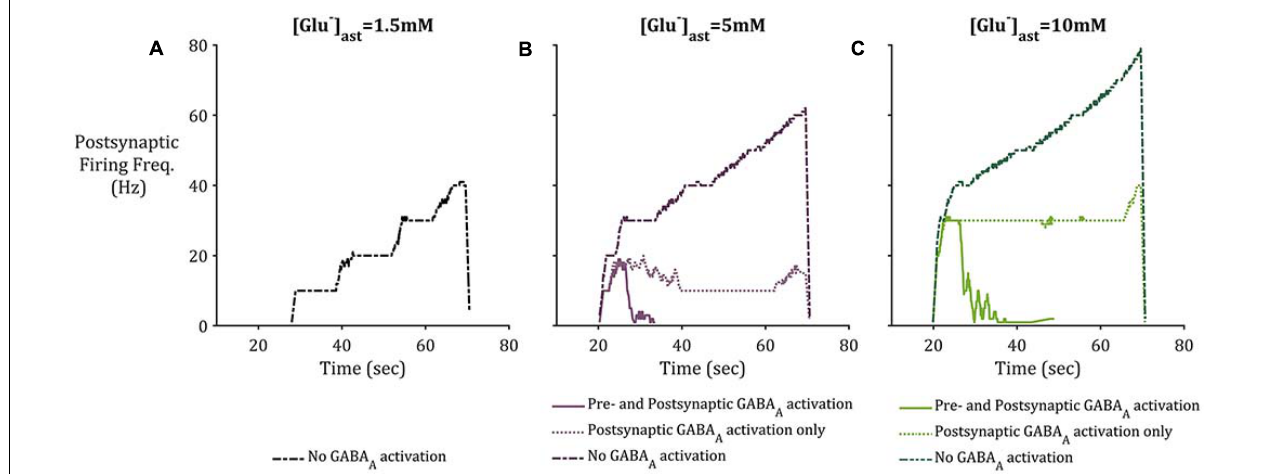
FIGURE 7 | Postsynaptic neuronal firing frequency where (A) basal [Glu] ast = 1.5 mM, (B) basal [Glu] ast = 5 mM, and (C) basal [Glu] ast = 10 mM. Within each plot results from the modeling simulation described above were recorded, where inclusion of astrocytic GAT-3 resulted in GABA-mediated activation of GABA A -Rs are either located on both presynaptic and postsynaptic neuronal membrane ( solid line), or the postsynaptic neuronal membrane only ( dotted line). Exclusion of GAT-3 and thus no GABA A -R mediated currents are included as control ( dash-dotted line). In all cases, the inclusion of GABA dynamics resulted in diminished postsynaptic activity, specifically where [Glu]ast = 1.5 mM, which resulted in no postsynaptic activity where GABA A -R activation was